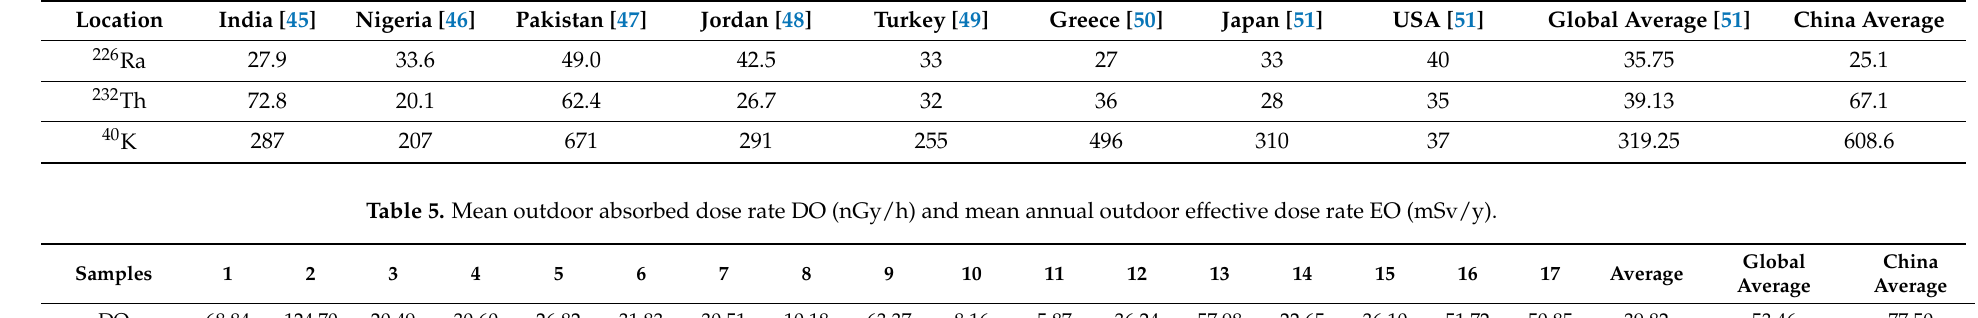
Table 4. Comparison of natural radioactivity of metal tailings in Tibet and other parts of the world [44].